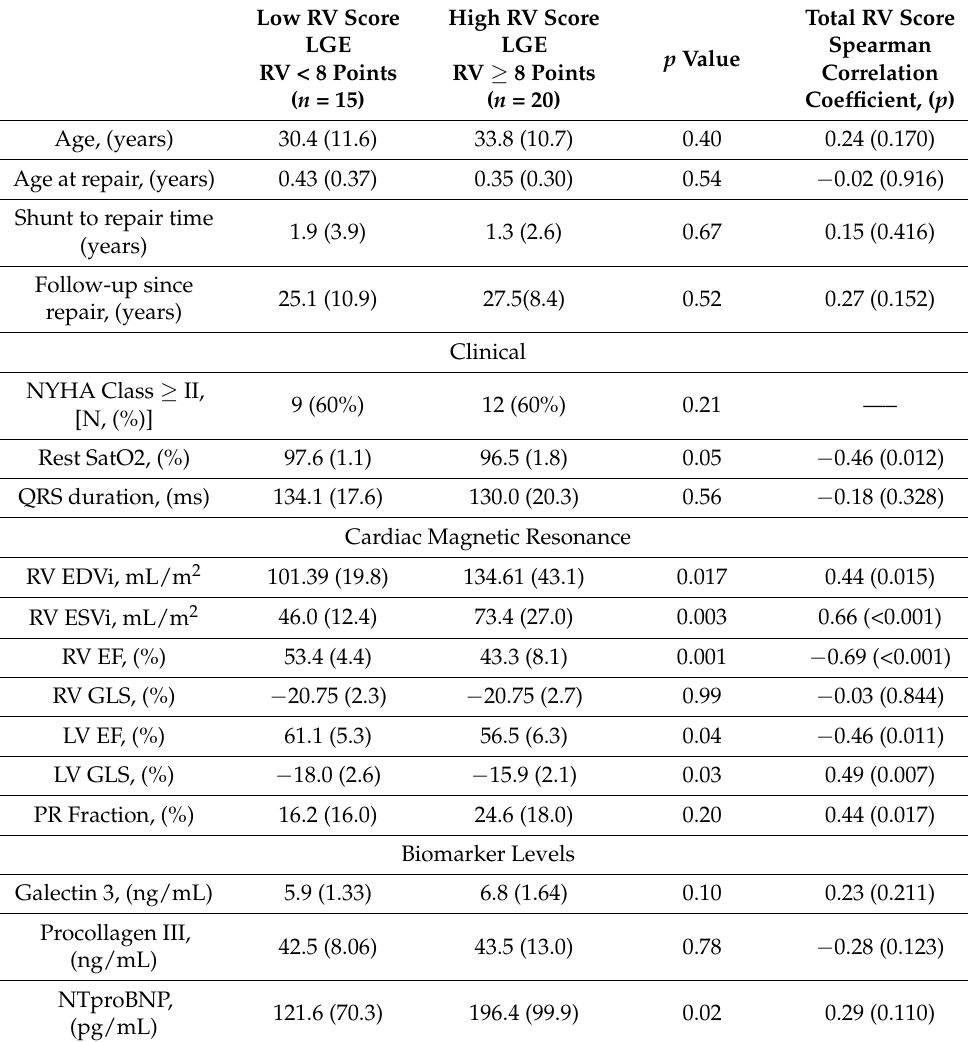
Table 2. Association of RV LGE to clinical markers, ventricular volumes, biventricular performance by CMR and blood biomarkers *.